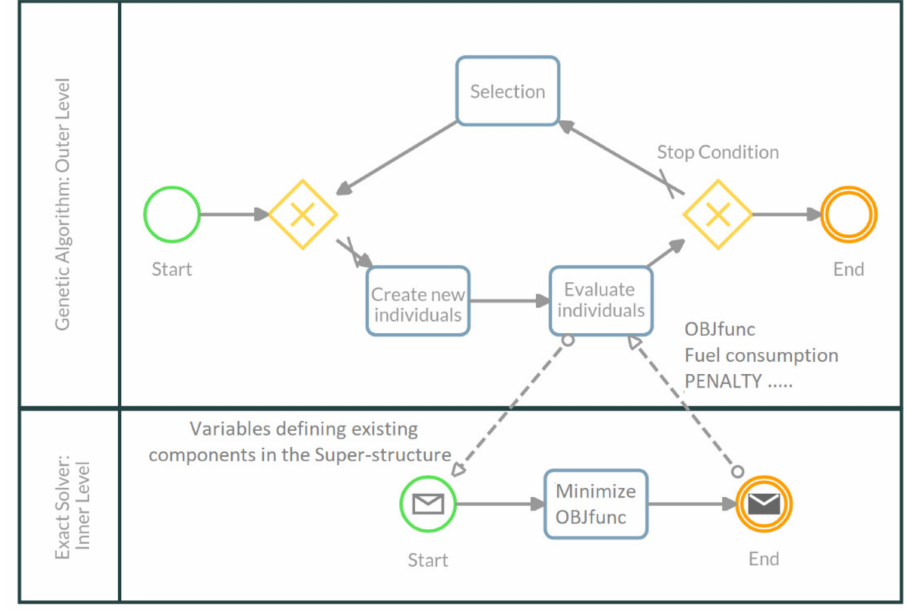
Figure 8. Scheme of the bi-level optimization